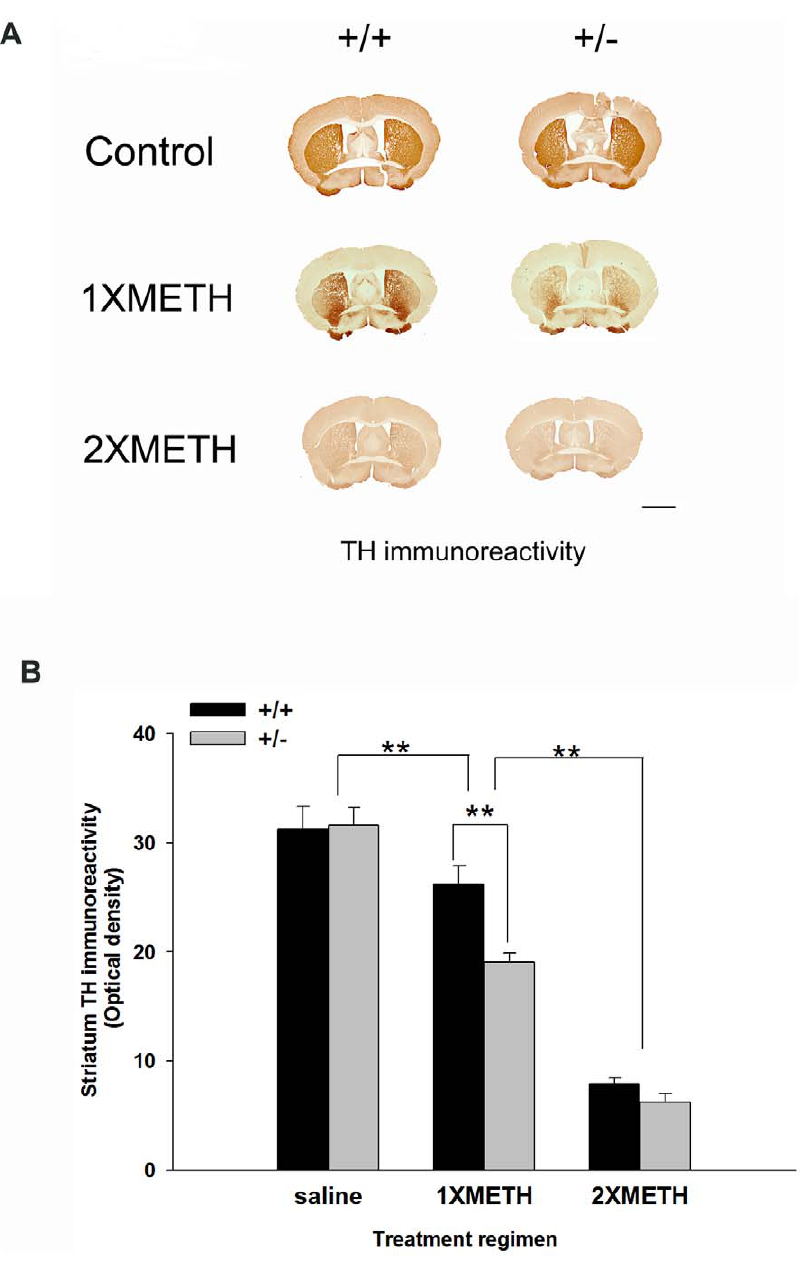
Figure 3. Nurr1 + / 2 mice exhibit greater reduction of striatal TH-immunoreactivity following METH exposure. (A) METH injection reduced THir in + / + and + / 2 mice following one time binge METH exposure (1X METH) and repeated binge METH exposure (2XMETH). Calibration=2 mm. (B) Quantitative THir fiber density analysis indicated that binge METH treatment significantly reduces THir in striatum and 2XMETH induced a further reduction of the THir in both + / + and + / 2 mice. There is a significant difference between saline and 1XMETH group (p , 0.001, Two-way ANOVA) and between 1XMETH and 2XMETH group (p , 0.001, Two-way ANOVA) in striatal THir. In addition, there is also a significant difference (p , 0.001) between + / + and + / 2 mice after 1XMETH injection.